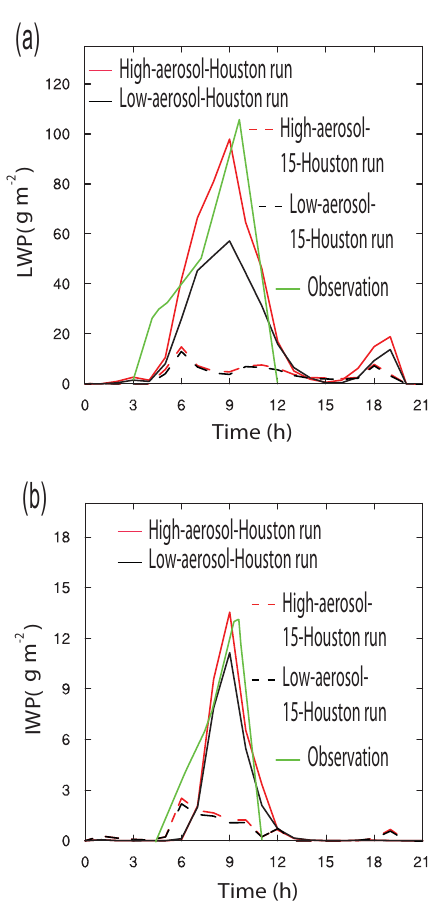
Figure 6. Same as Fig. 5, but for the Houston